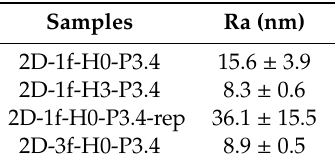
Table 3. Surface roughness of 2D coatings on CoCr discs (average ± standard deviation).